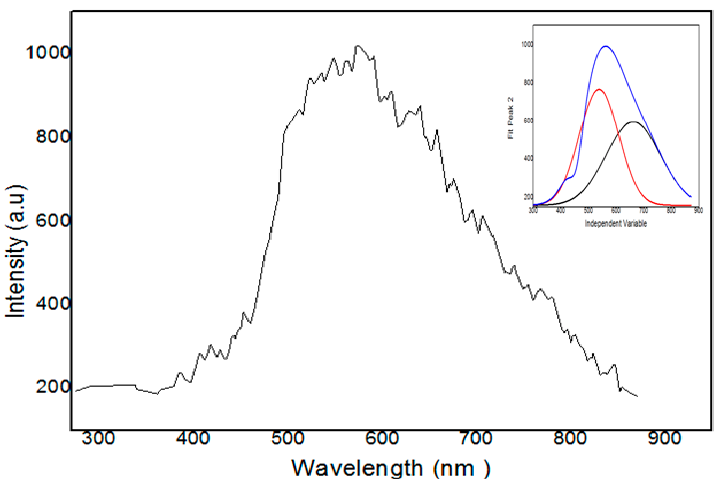
Figure 11. Electroluminescence of the cross-section of the In 0.1 Ga 0.9 N LED.